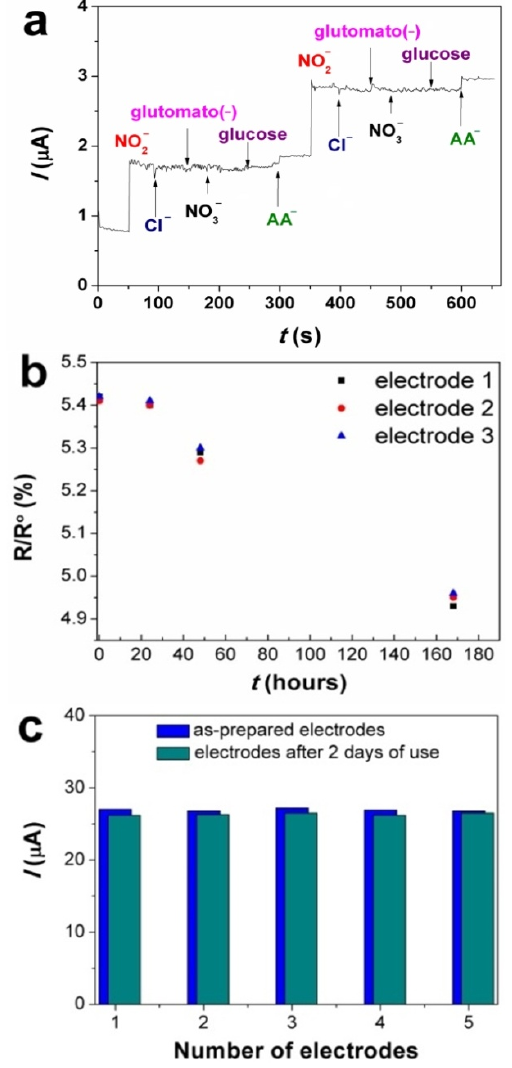
Figure 7. Amperometric response of the Au/FePc(tBu) 4 /GCE to various interfering analytes ( a ); stability of the amperometric response (R) of the Au/FePc(tBu) 4 /GCE after the addition of 10 µ M NO 2 − ( b ); and the repeatability and reproducibility of the Au/FePc(tBu) 4 /GCE ( c ).